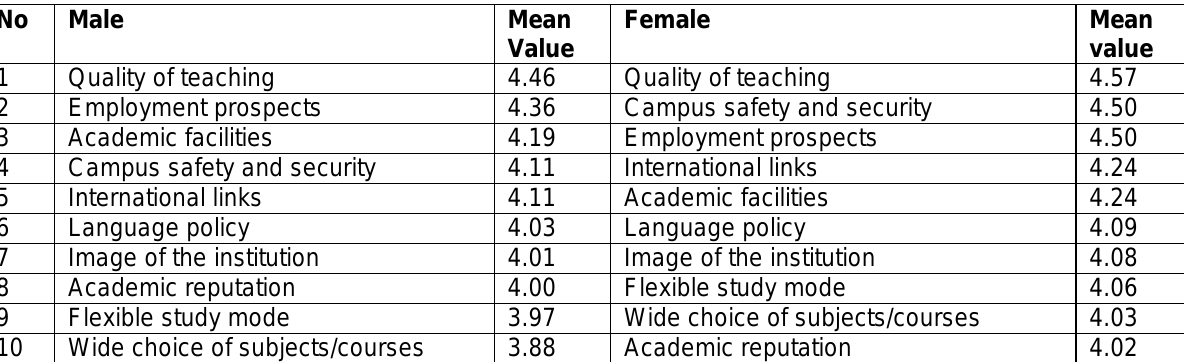
Table 1: Top ten choice factors according to gender